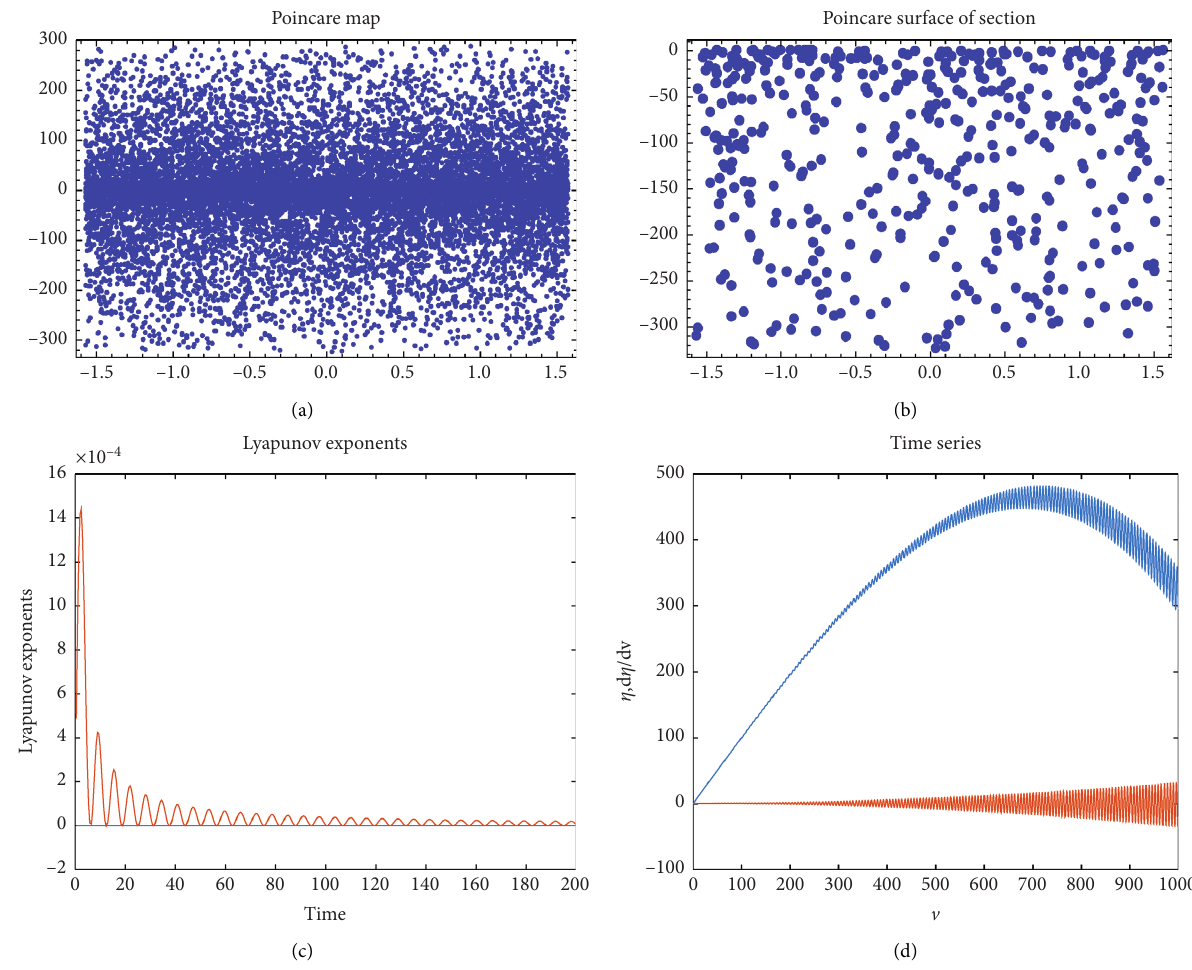
� 3 . 36 E + 09 , D � − 4 E + 08 , B � 1596 . 387 , C � − 103631 ,E � 200 . 1022 , ∗ ∗ ∗ ∗ ∗